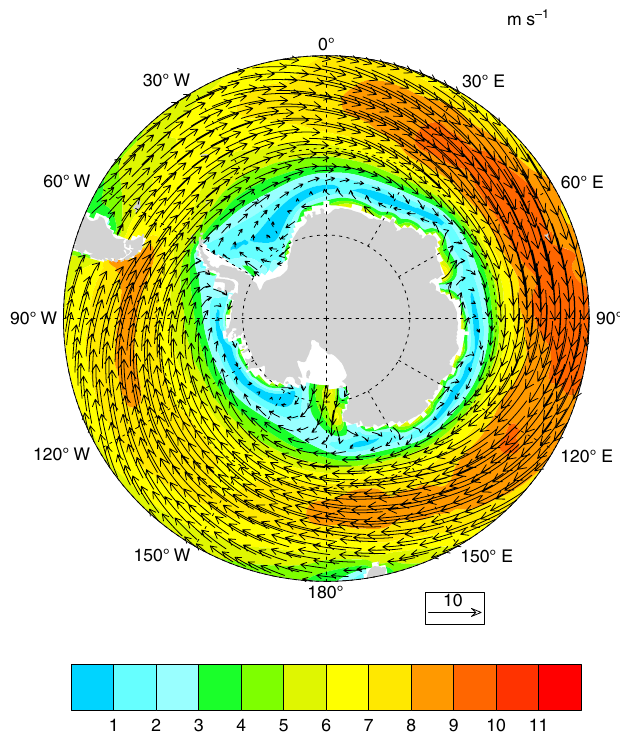
Fig. 2 October climatological winds. The October climatological winds averaged from 1979 to 2015 from ERA-Interim. Colored shading indicates the wind magnitude in meters per